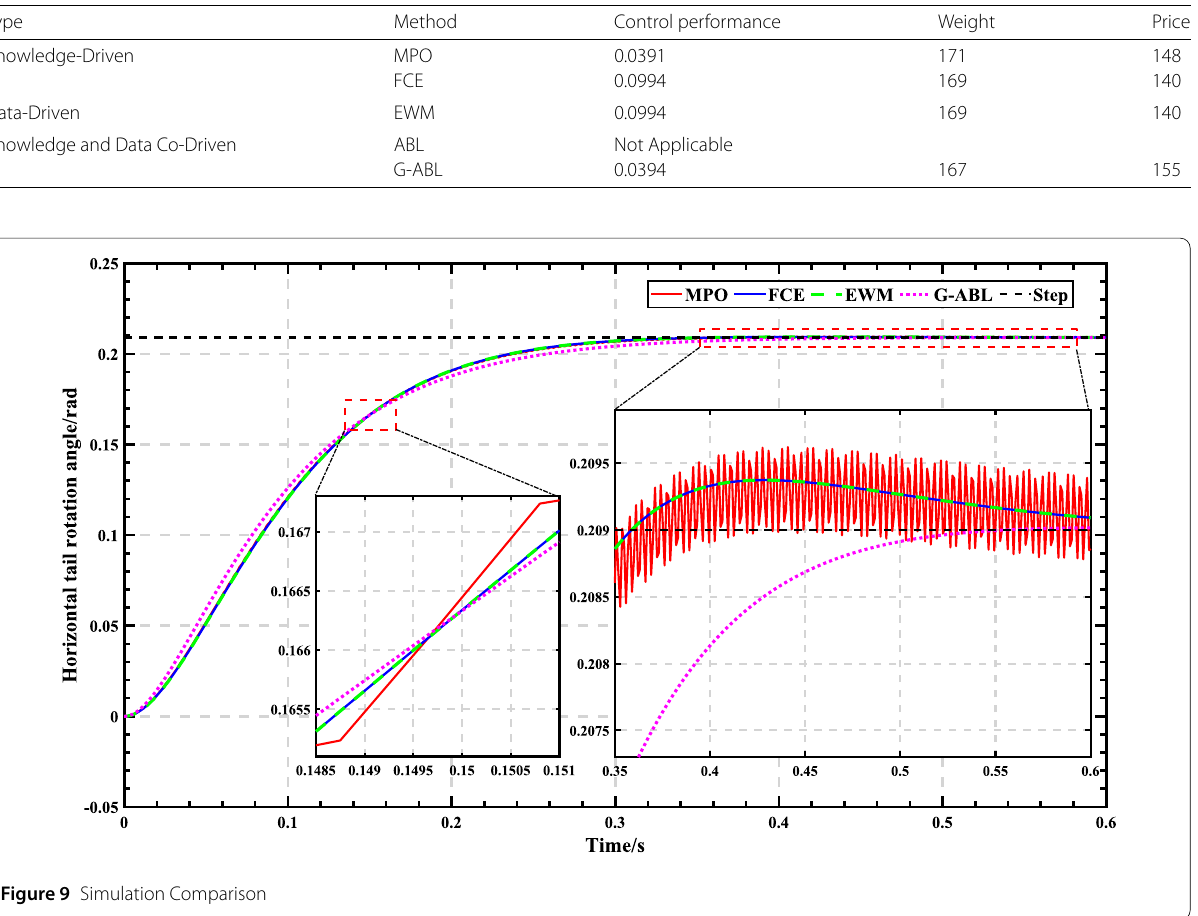
Table 3 Decision results based on various methods